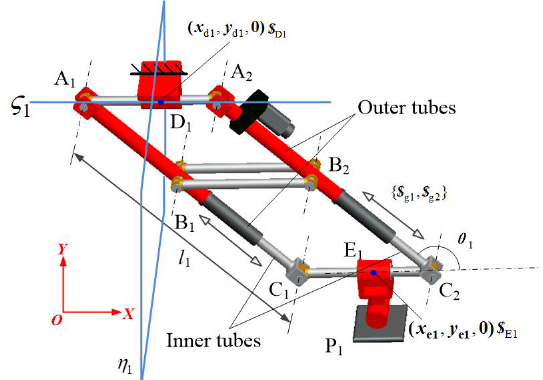
Figure 2. PLMEs limb.